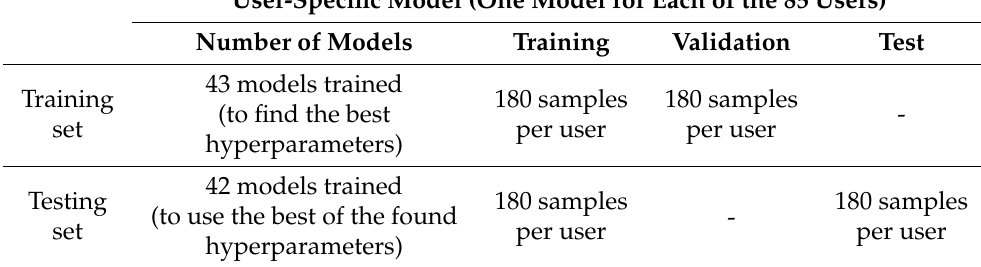
Table 1. Dataset distribution to evaluate user-specific models